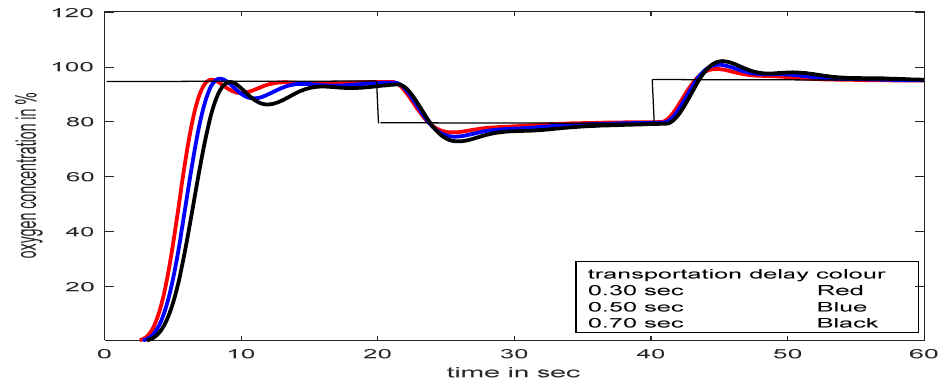
Figure 21. Response with SFPIMRAC for transport delay and load/set ‐ point variations. Figure 20. Process responses with SFPIMRAC for time delay and load/set ‐ point variations.